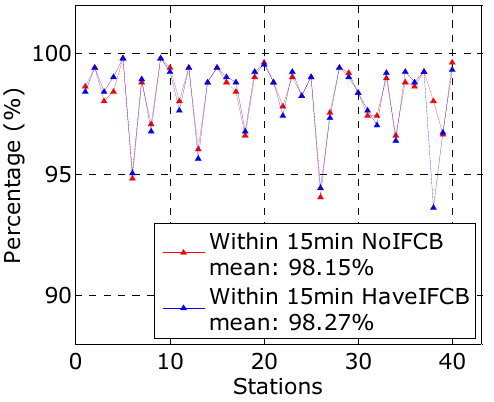
Figure 9. Fixing percentage of kinematic PPP with different strategies for an observation duration of 15 min for each station. Receivers with homogeneous type are used as rover sites.